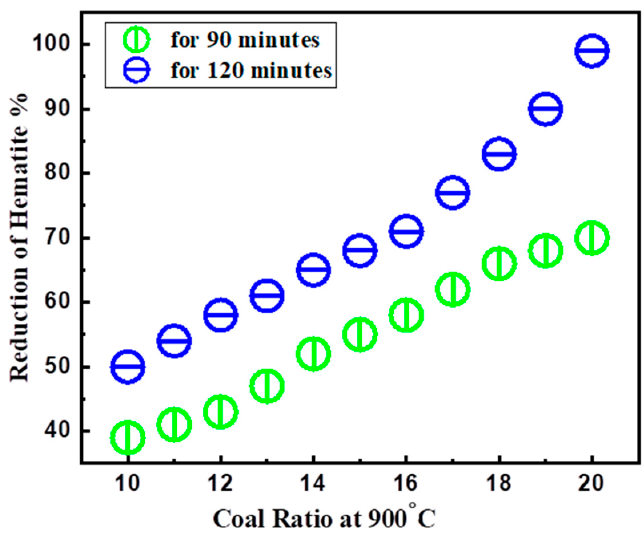
Figure 5. Effect of coal ratio at 900 °C for reduction of hematite.